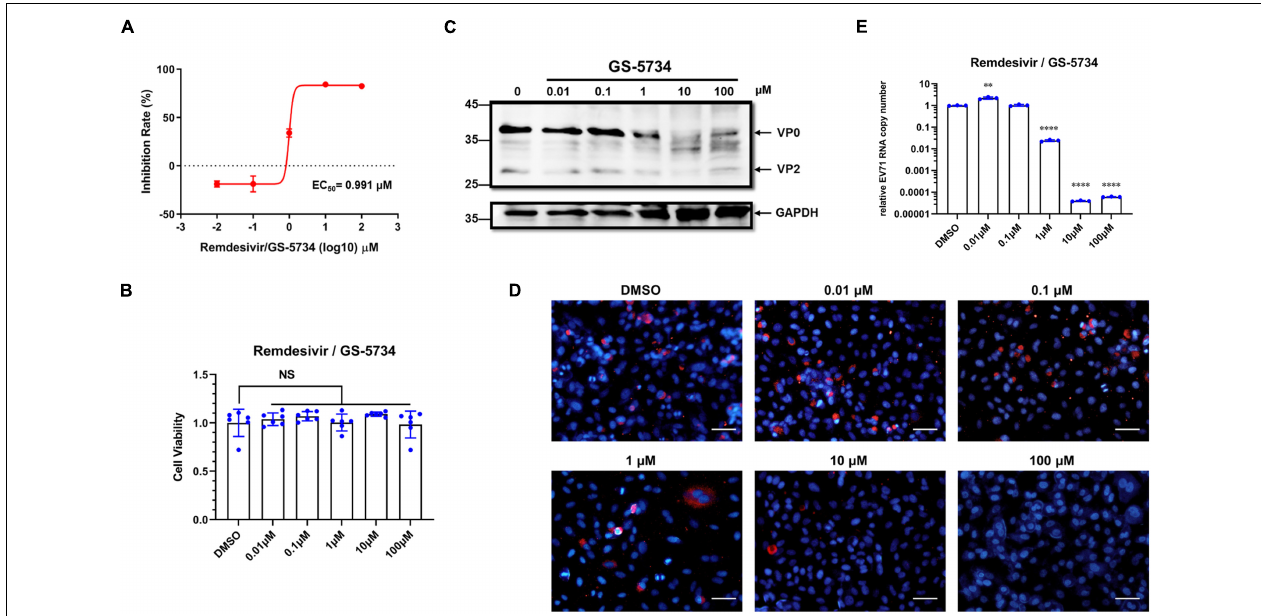
FIGURE 1 | Remdesivir potently inhibits EV71 infection without significant cytotoxicity. (A) HeLa cells were infected with EV71 (MOI = 1) and treated with varying concentrations of remdesivir at 1 hpi. The viral RNA copy number was quantified by qRT-PCR at 24 hpi (mean ± SD, n = 3). (B) Cell viability after culture with different doses of remdesivir at 24 hpi assessed using a CCK8 assay (mean ± SD, n = 6). (C) Western blot of EV71 VP2 protein expression in HeLa cells. HeLa cells were infected with EV71 (MOI = 0.5). After adsorption, the cells were treated with the indicated concentrations of remdesivir and collected at 24 hpi. Then, the proteins were resolved by SDS-PAGE and western blotting. (D) Fluorescence microscopy examination of EV71-infected HeLa cells treated with different amounts of remdesivir (24 hpi). The dsRNA-specific antibody J2 (red) was used for staining viral dsRNA replication intermediates, and nuclei were labeled with Hoechst 33258 (blue). Bar = 100 µ m. (E) Cell culture supernatants collected from (A) were used to infect HeLa cells, and after 1 h of adsorption at 37 ◦ C, fresh medium was added. At 24 hpi, cells were collected and subjected to viral RNA copy number quantification by qRT-PCR (mean ± SD, n = 3). NS, P > 0.05, * P < 0.05, ** P < 0.01, *** P < 0.001, and **** P <